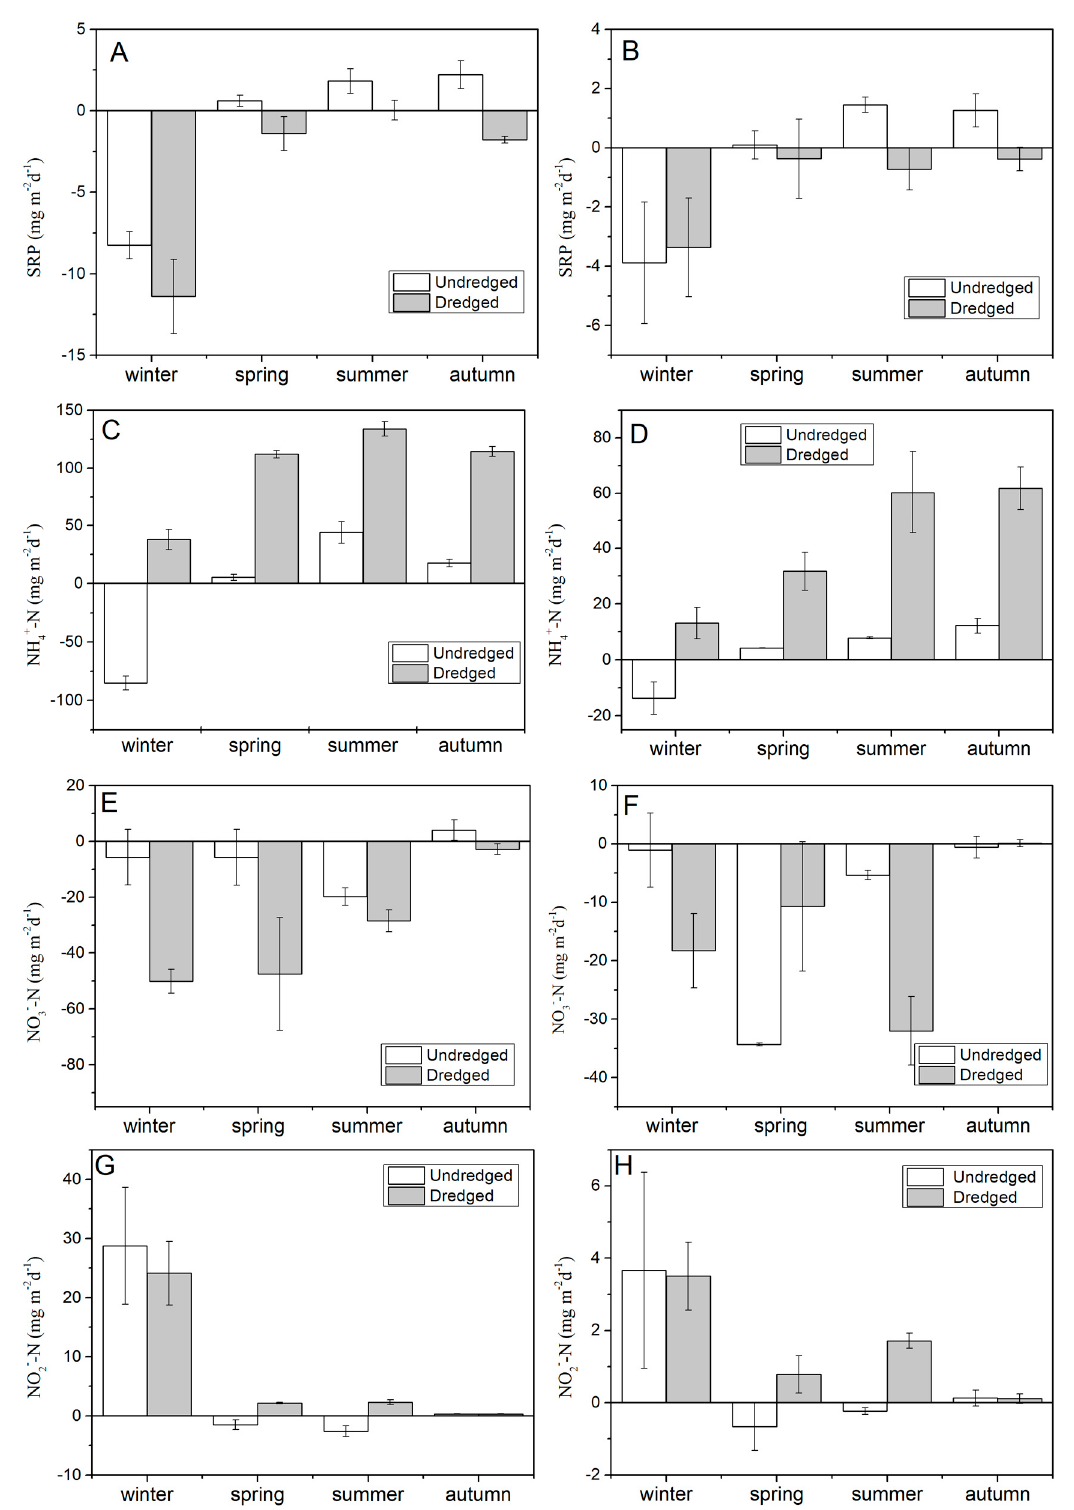
Figure 7. Fluxes of SRP and inorganic nitrogen across the sediment–water interface in undredged and dredged sediments of the Inner Bay ( A , C , E , G ) and Outer Bay ( B , D , F , H ) in January, April, July, and October 2013, Error bars represent ±1 SE of triplicate samples.